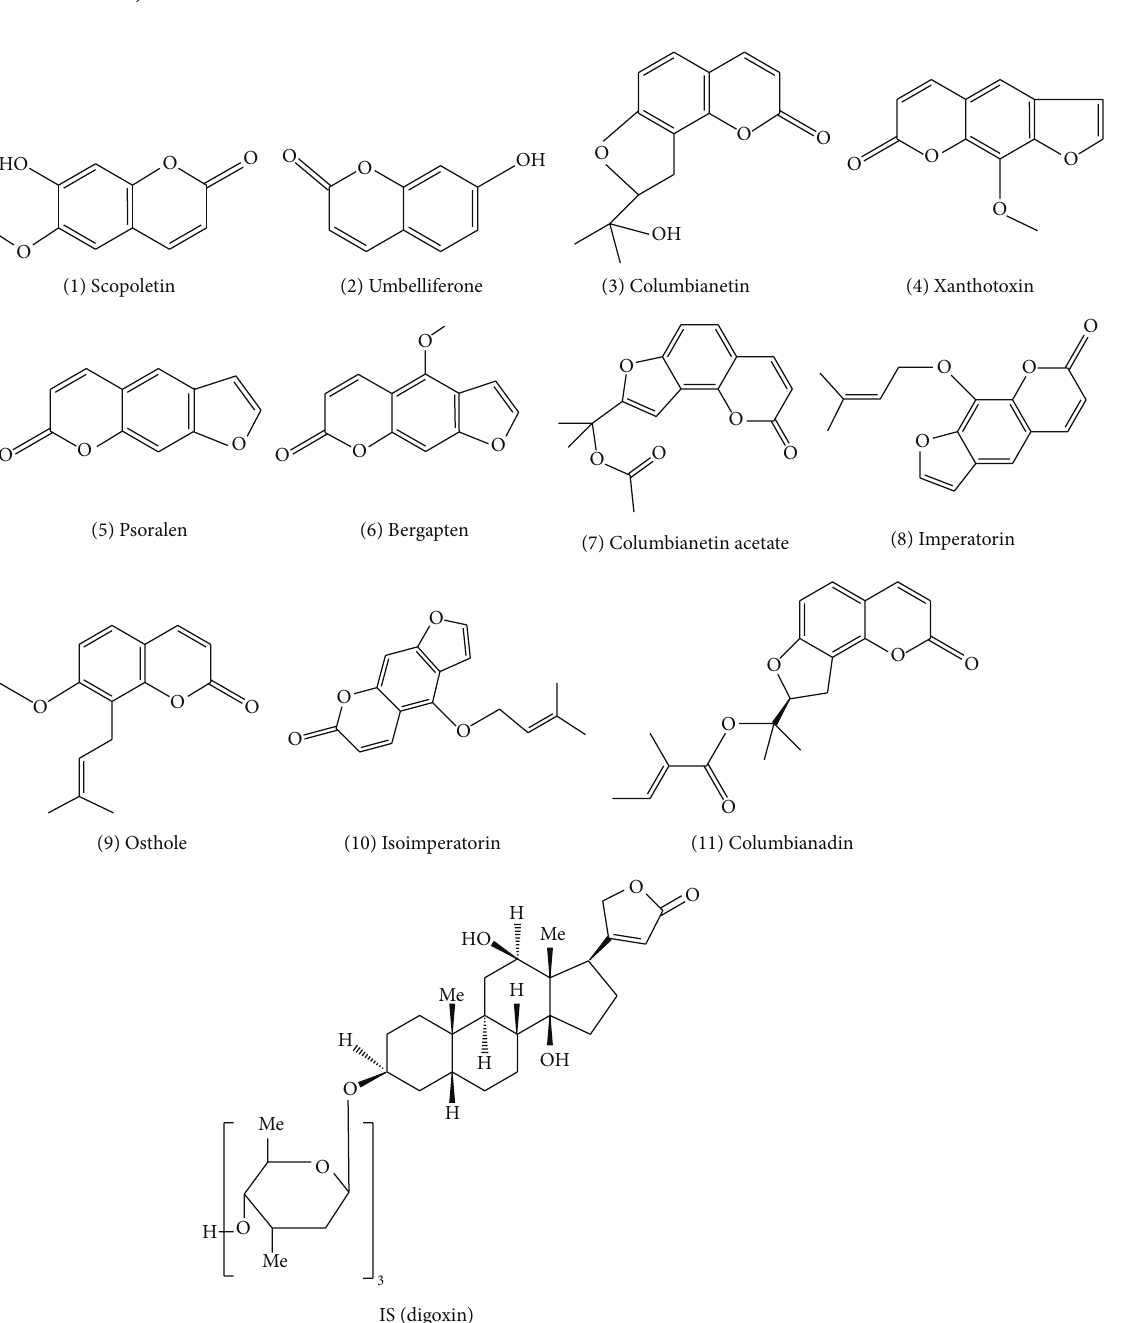
Figure 1: Chemical structures of eleven major active